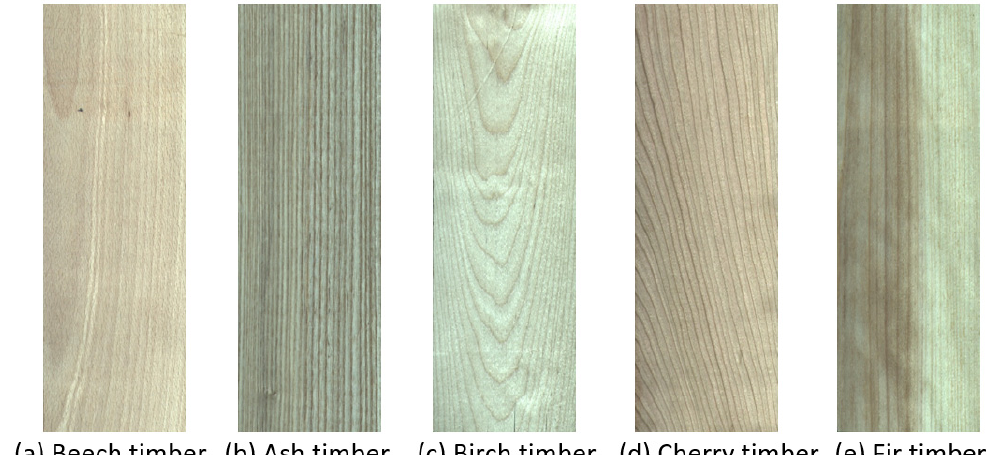
Figure 2. Color images of sawn timber.